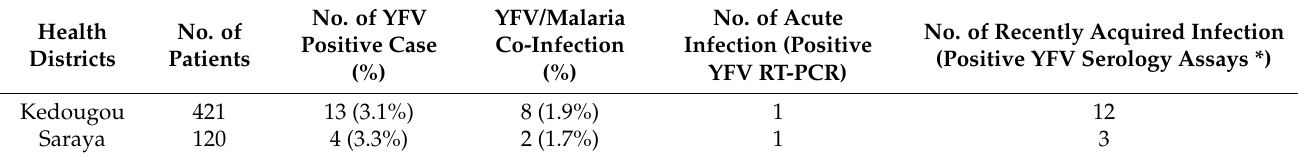
Table 2. Summary of YF cases detected in the Kedougou region (* ELISA +